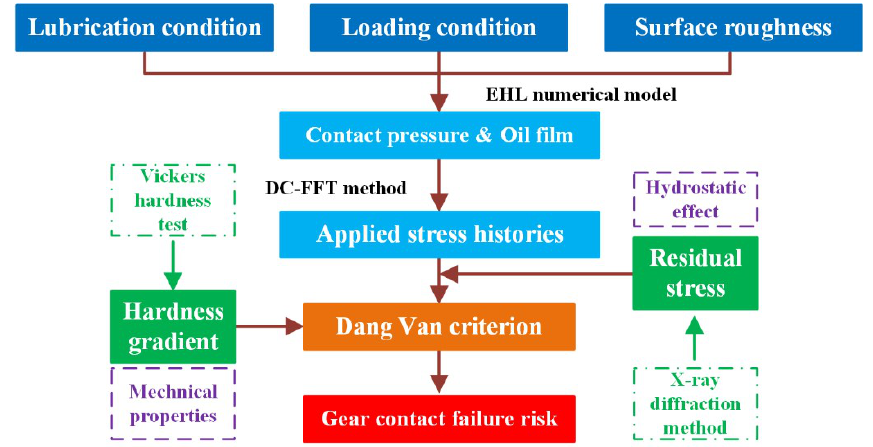
Figure 1. Double immunofluorescence staining of rat liver sections (GdCl 3 treatment) with antibodies Figure 6. The technical route of contact failure risk evaluation with EHL considering different surface directed against ED-1 (green) and MPO (red) followed by fluorescence immunodetection. Liver sections roughness from different time points of study are shown: control ( A ); 3 h ( B ) and 24 h ( C ). Results shown are representative pictures of six animals and six slides per time point. (Original magnification 200